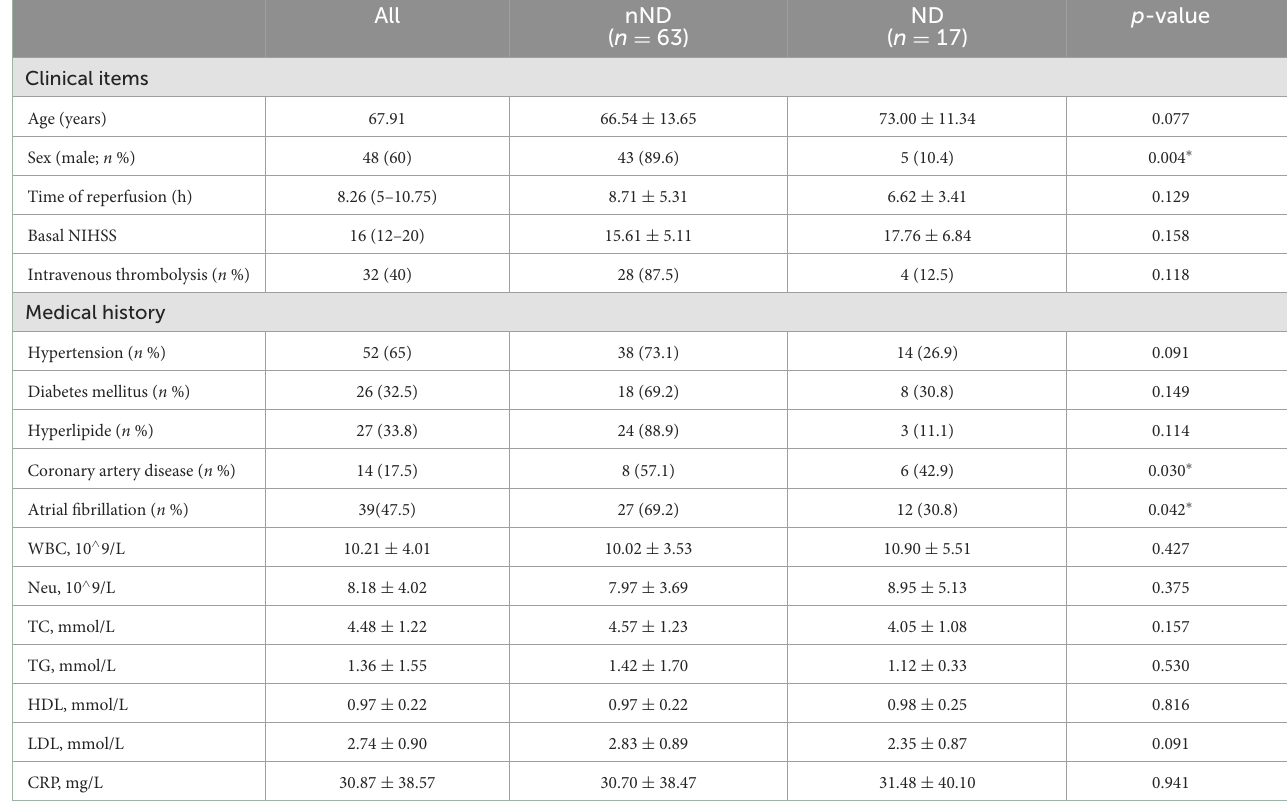
TABLE 2 Clinical Baseline Characteristics in ND and